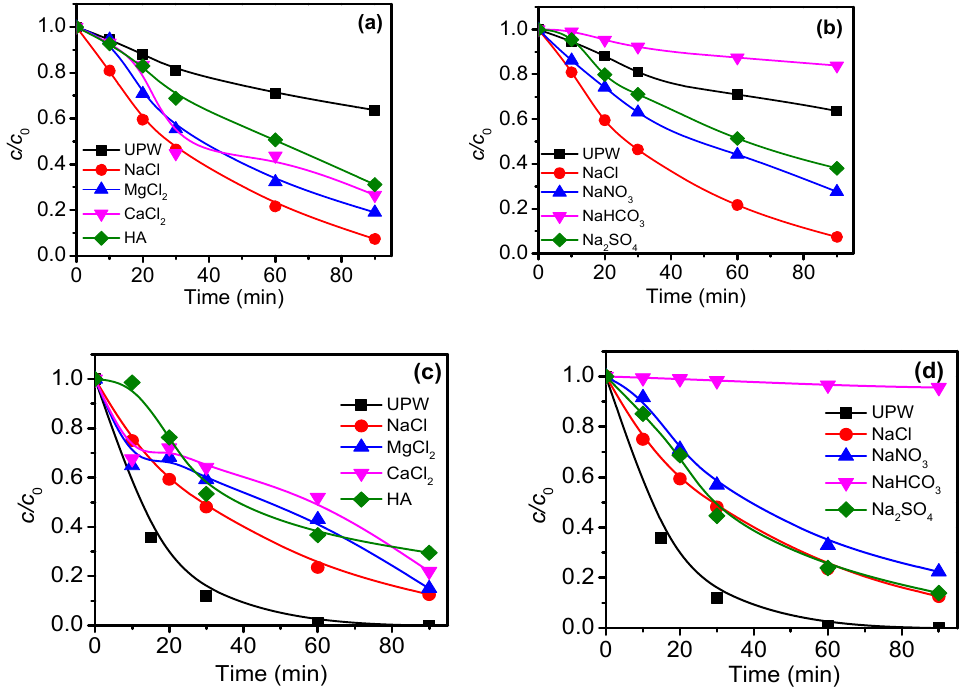
Figure 10. Effect of different ions and HA on the efficiency of FB 1 (1.39 μ mol/dm 3 ) degradation at